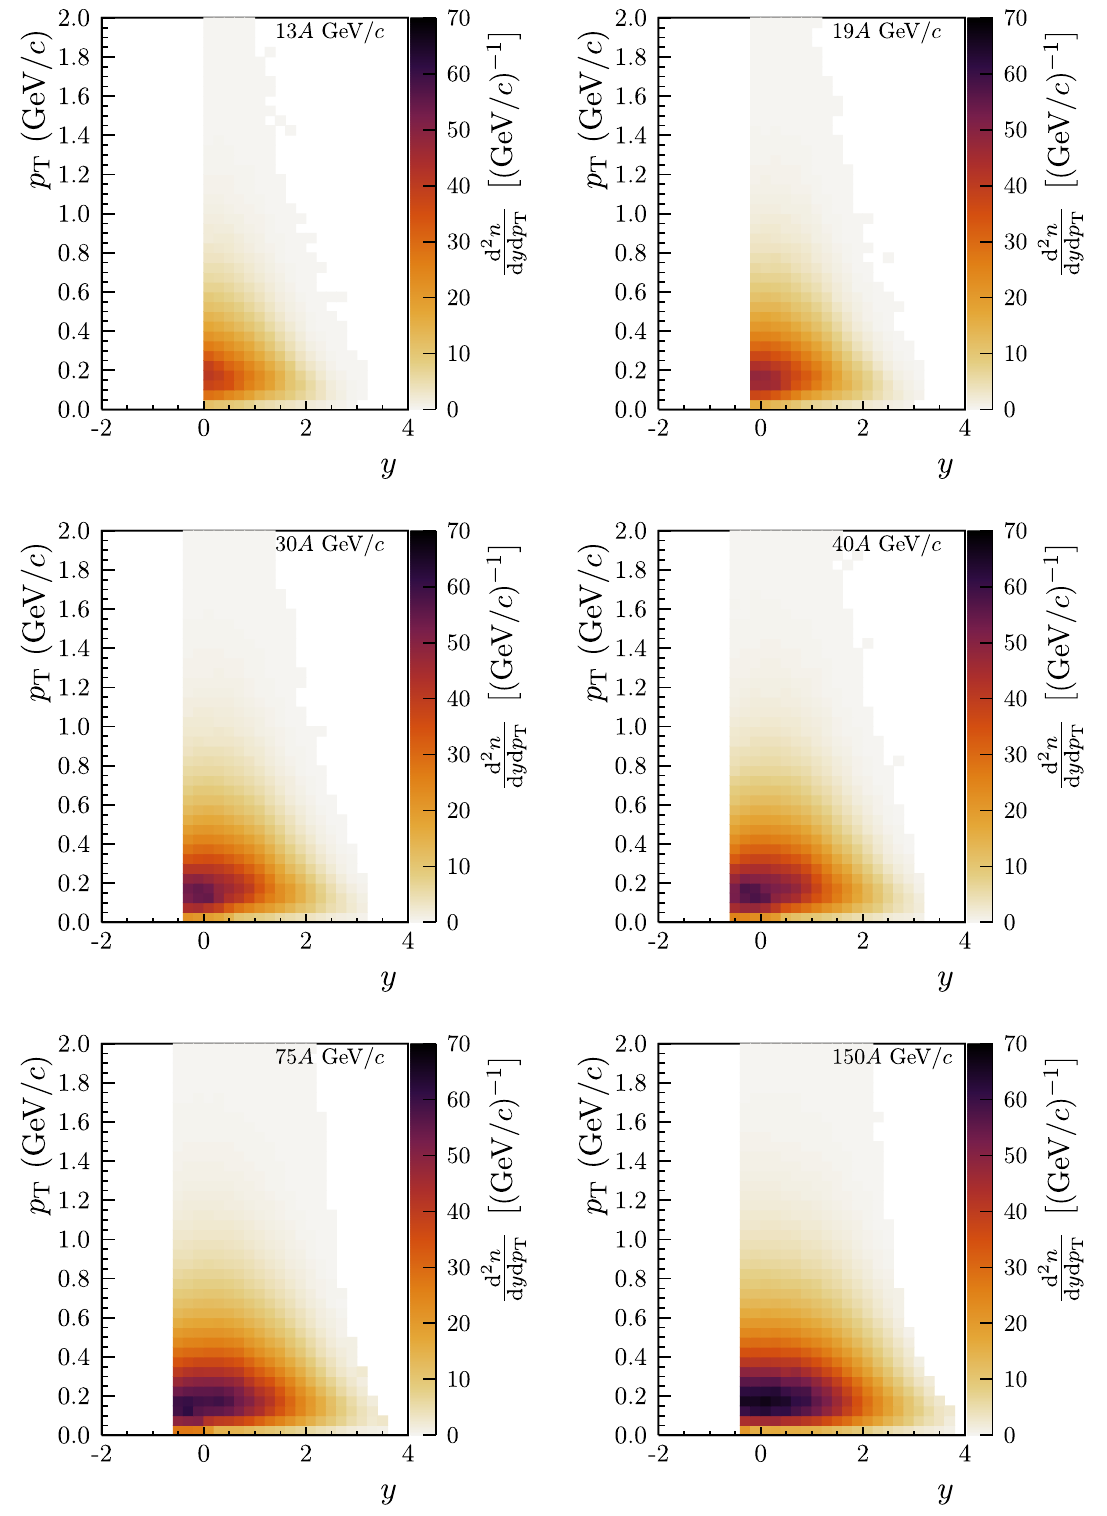
Fig. 9 Corrected double-differential spectra d 2 n of negatively charged pions produced in the 5% most central Ar+Sc collisions at beam momenta d y d p T of 13 A , 19 A , 30 A , 40 A , 75 A and 150 A GeV /